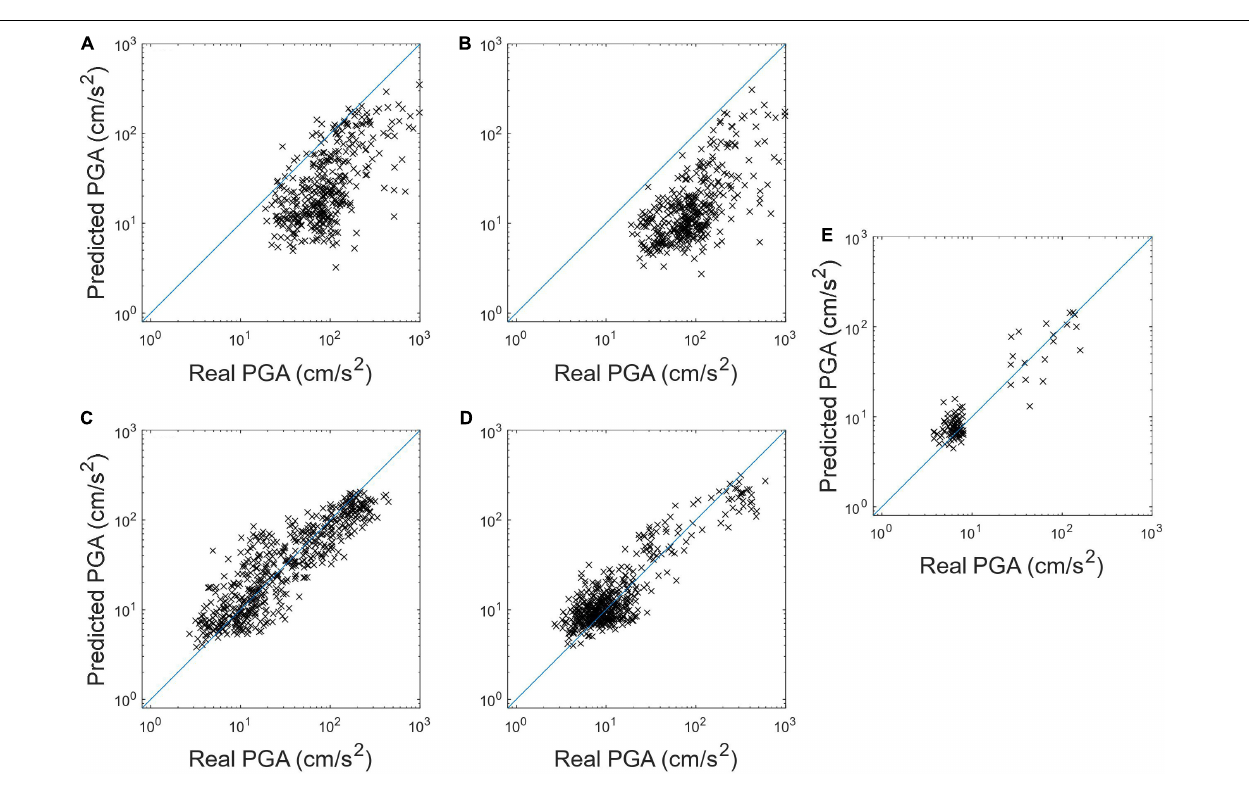
of the EEW System of the National Center for Research